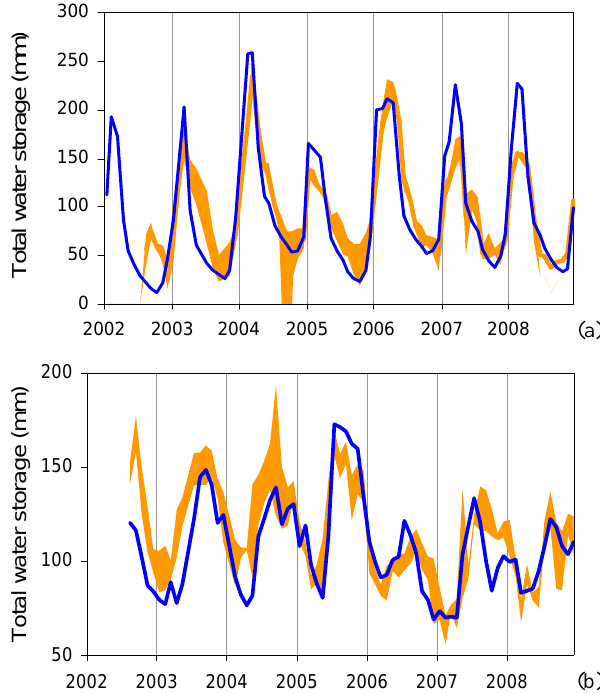
Fig. 5. Comparison of large scale average TWS derived from three GRACE products (orange band) and AWRA (blue line) for the (a) Timor sea drainage division, and the (b) Murray